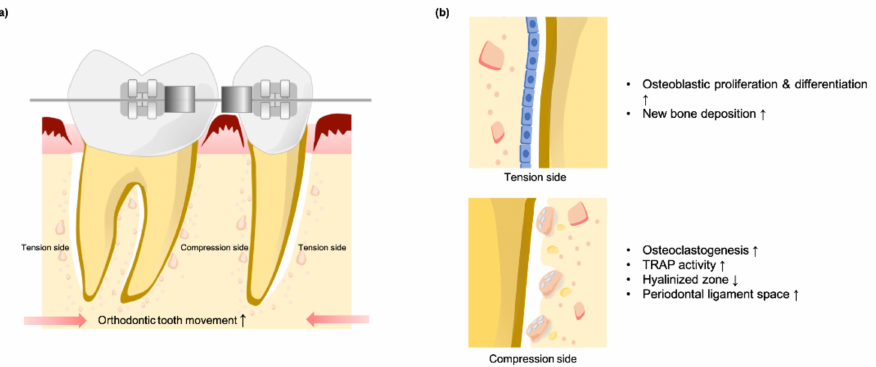
Figure 2. Illustration of orthodontic teeth movement under SMF stimulation in ( a ) the tension side and ( b ) the compression